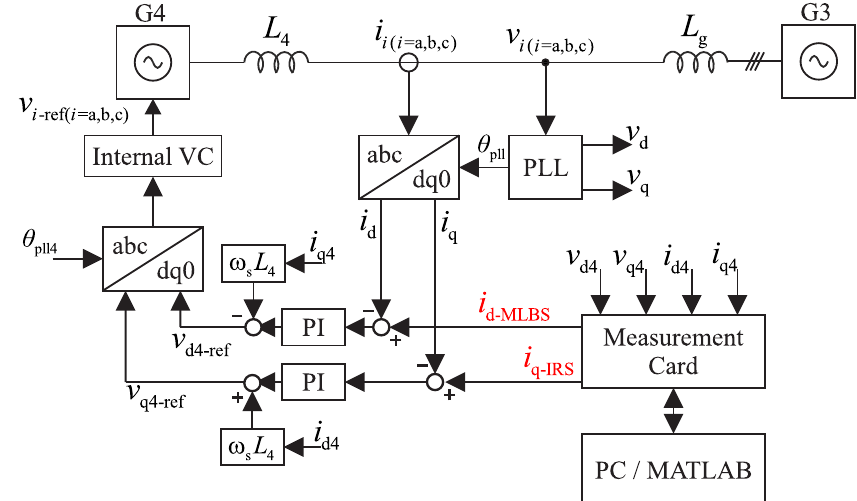
Figure 8. Overview of two voltage amplifiers configured to emulate a converter connected to a grid with finite